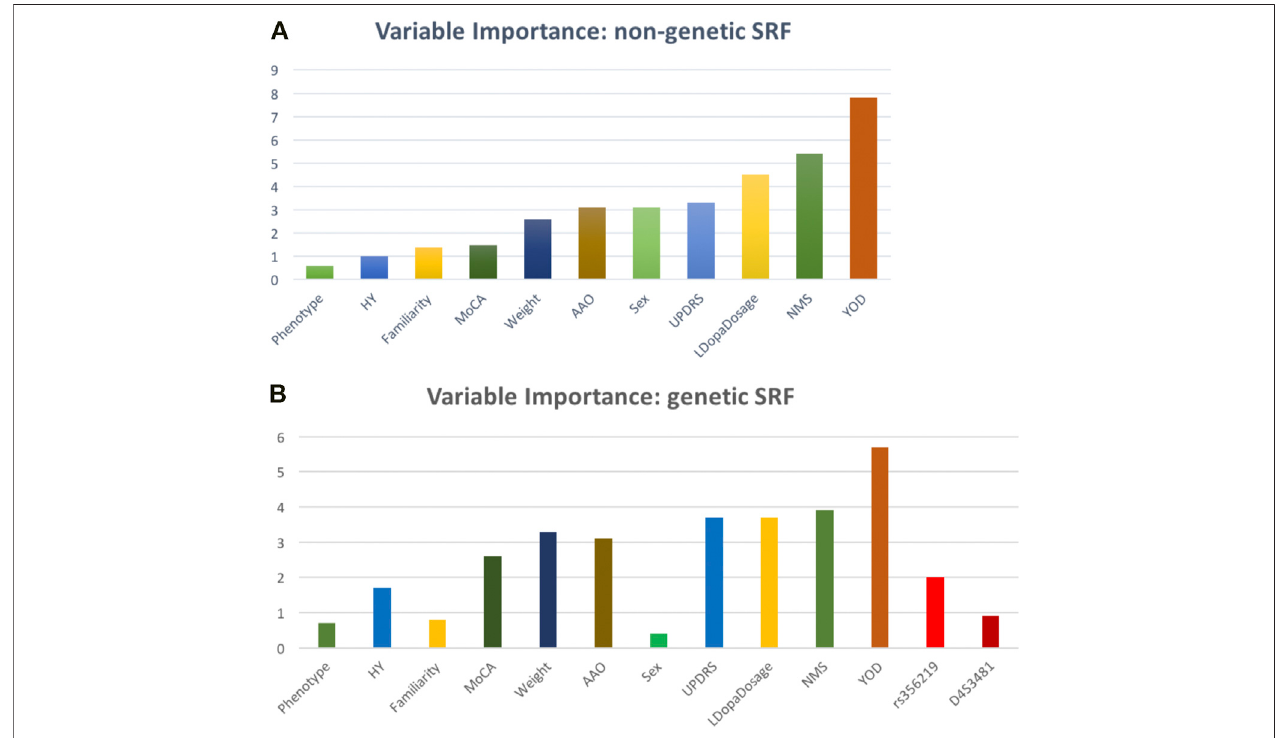
FIGURE 2 | Relative variable importance (%) of the LID risk predictors tested within the survival random forest (A) excluding and (B) including genetic ( SNCA ) features.